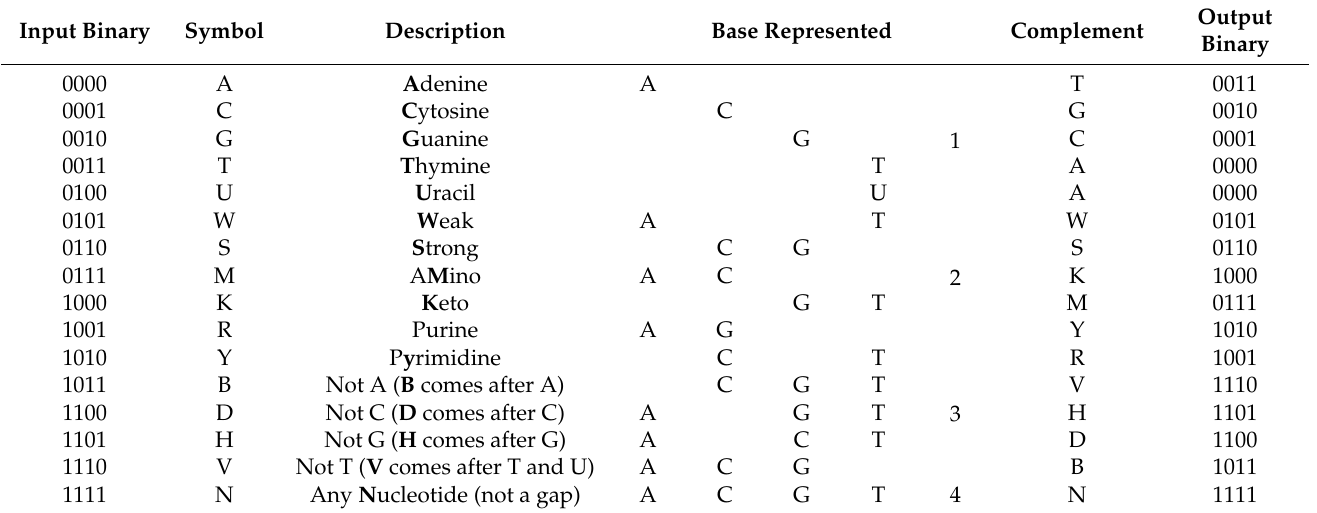
Table 4. Complimentary mapping rules.